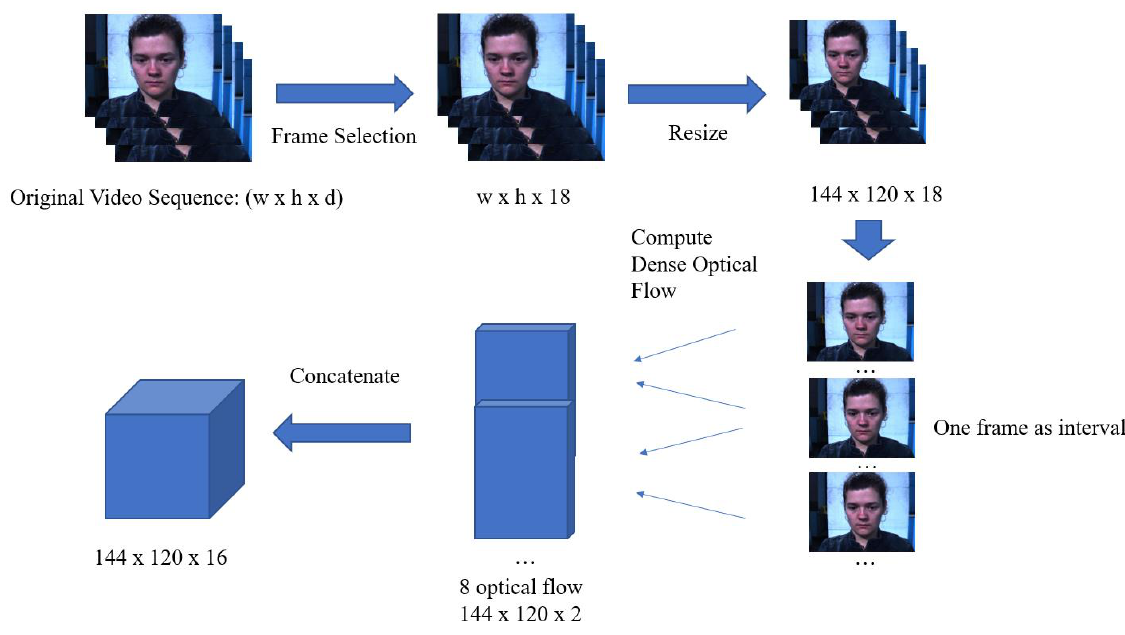
Figure 6. Generation of the optical flow sequence.